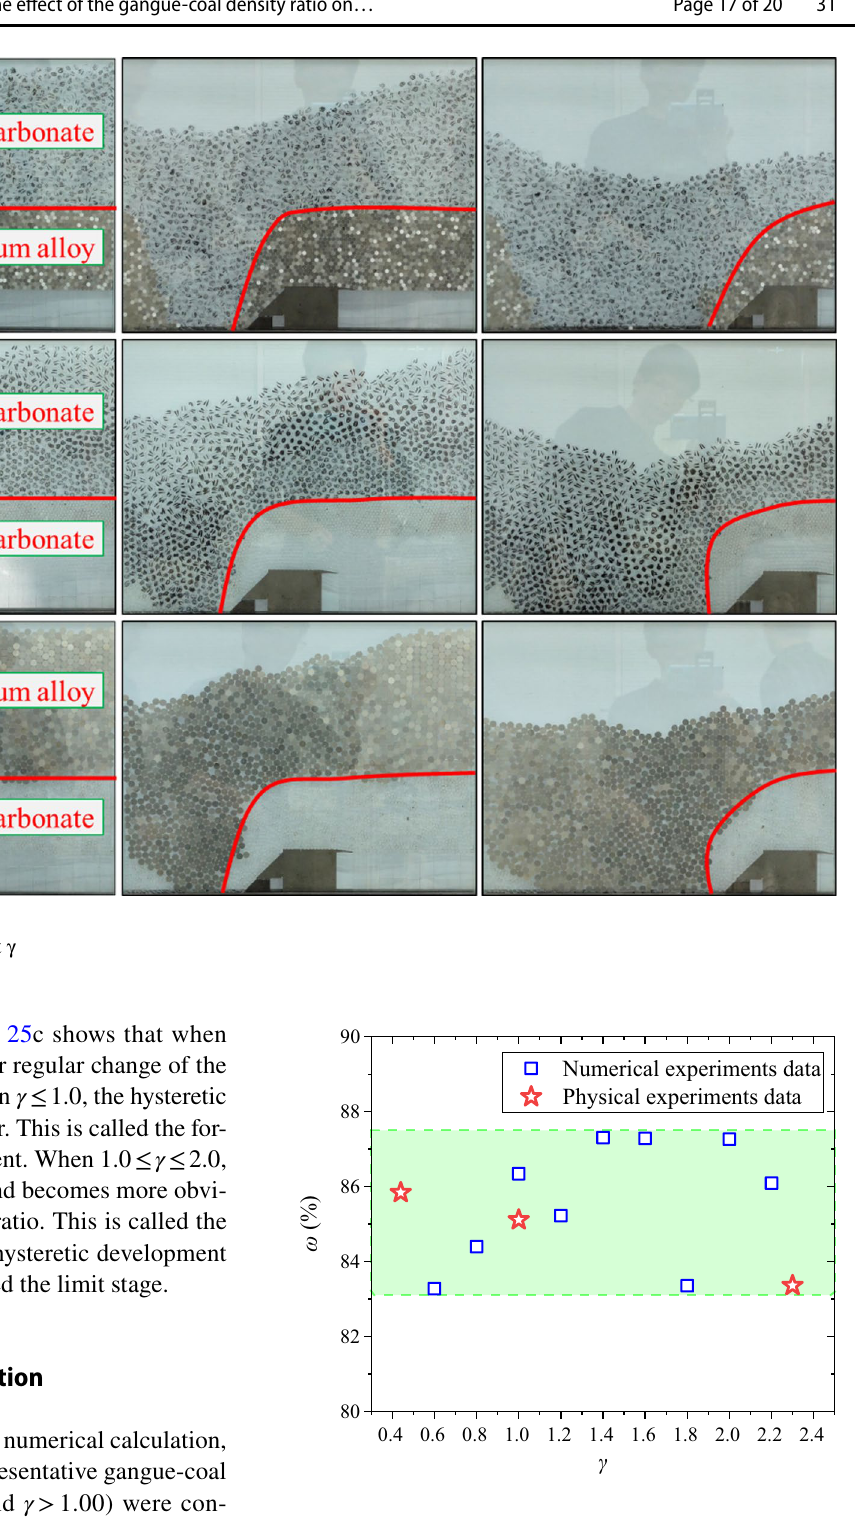
Fig. 27 Comparison of top coal recovery data obtained from physical experiments and numerical